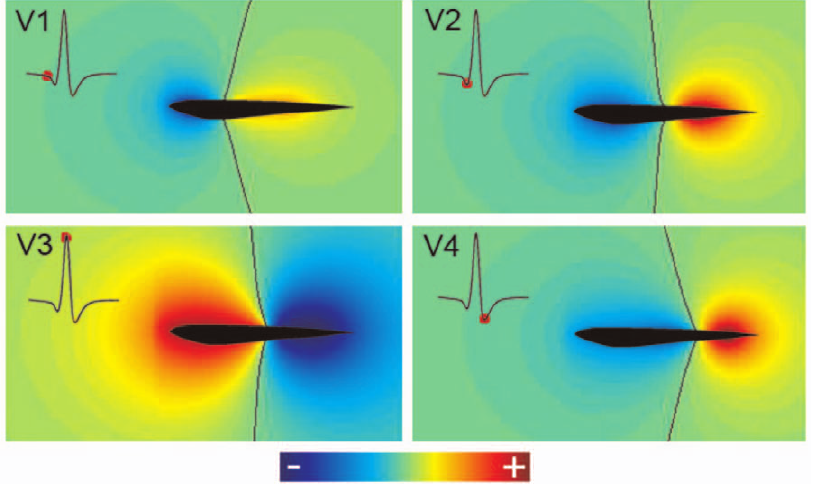
Figure 4. Normalized electric potentials, on the sagittal plane, at the peaks of the rostro-caudal potential difference. Each image corresponds to the instant when the head to tail EOD reaches the peaks of the waves V 1 , V 2 , V 3 and V 4 . Black lines indicate the points where the potential is zero. Insets show the head to tail EOD, with red dots indicating the peaks of the 4 waves.